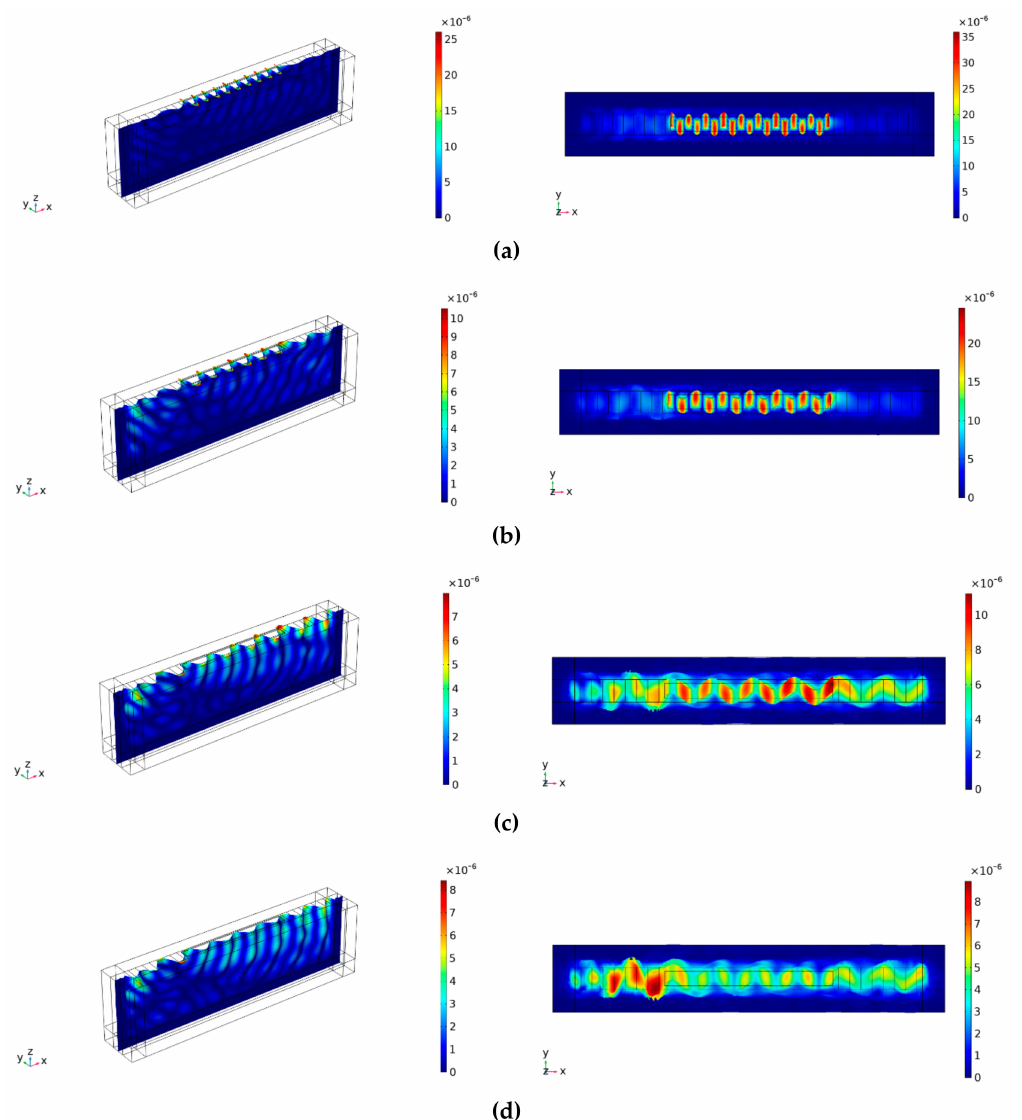
Figure 7. Snapshots of sectional views on a Y + 36 ◦ cut substrate with di ff erent thicknesses and materials (first column spatial displacement, second column displacement along the Y-direction) ( a ) 0.03 λ -thick gold wave-guide layer at 455 MHz; ( b ) 0.025 λ -thick platinum wave-guide layer at 421 MHz; ( c ) 0.035 λ -thick titanium wave-guide layer at 438 MHz; and ( d ) 0.03 λ -thick silicon dioxide wave-guide layer at 449